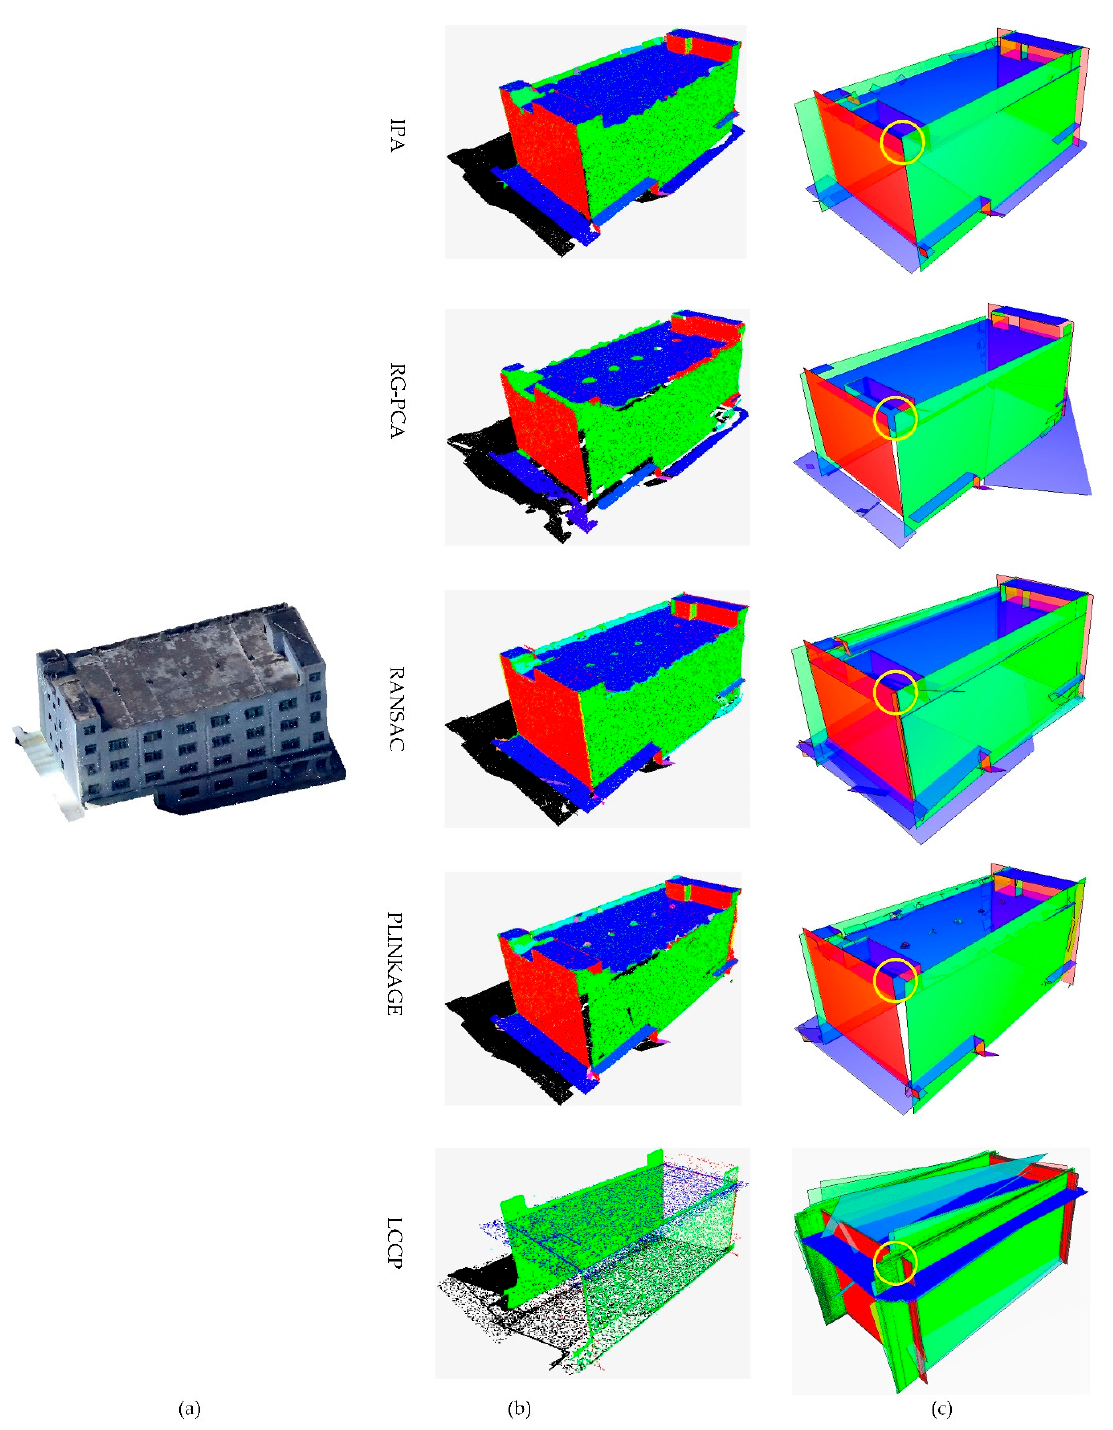
Figure 13. Comparison of the planar abstraction quality of building 3. ( a ) Building point cloud, ( b ) planar abstractions, and ( c ) extracted planes approximated by a set of planar polygons.